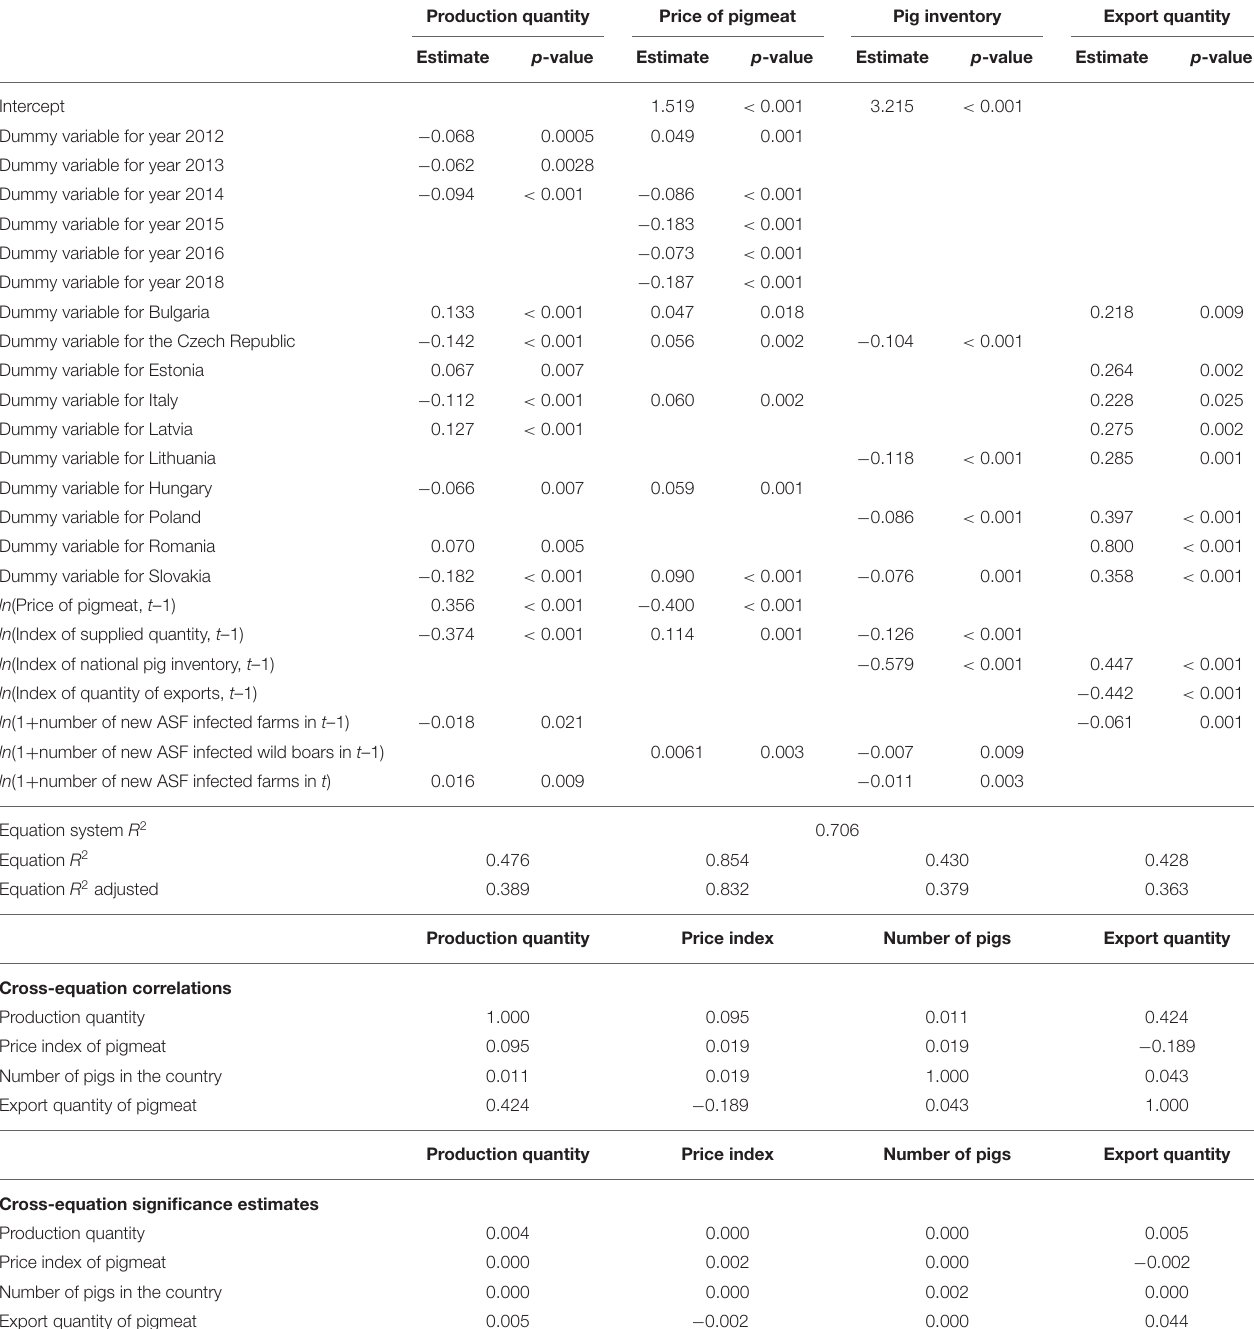
TABLE 4 | Estimation results for a system of four simultaneous equations describing annual change in the logarithm of the national pig inventory, quantity of pigmeat produced, quantity of pigmeat exported and the price of pigmeat (class